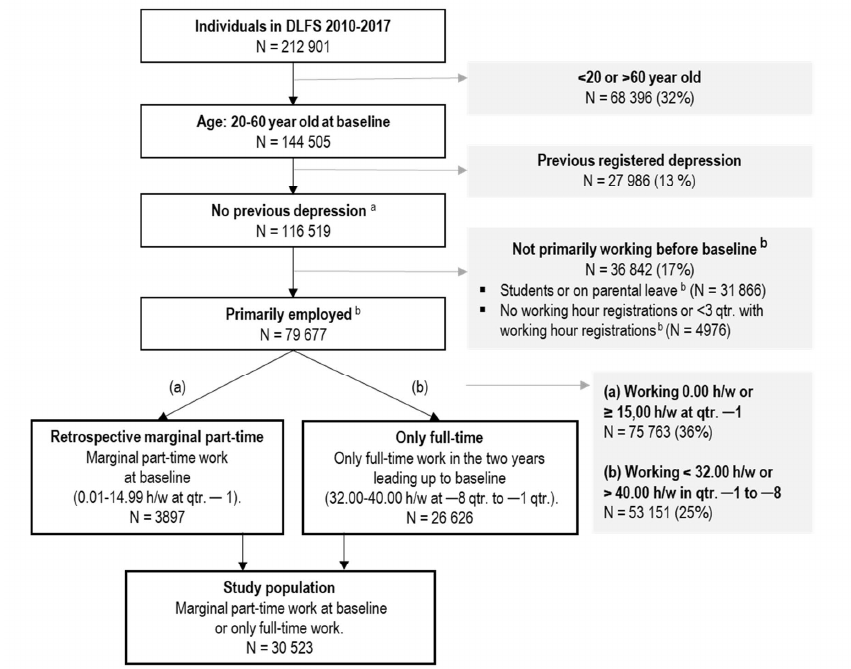
Figure 1. Flowchart of the study popula- tion with the retrospective trajectories of marginal part-time work. a No registration of a diagnosed depressive episode or pur- chasing of anti-depressant drugs before baseline. b In the two years before baseline, not receiving the State Educational Grant (SU), parental leave benefits or having regsitered working